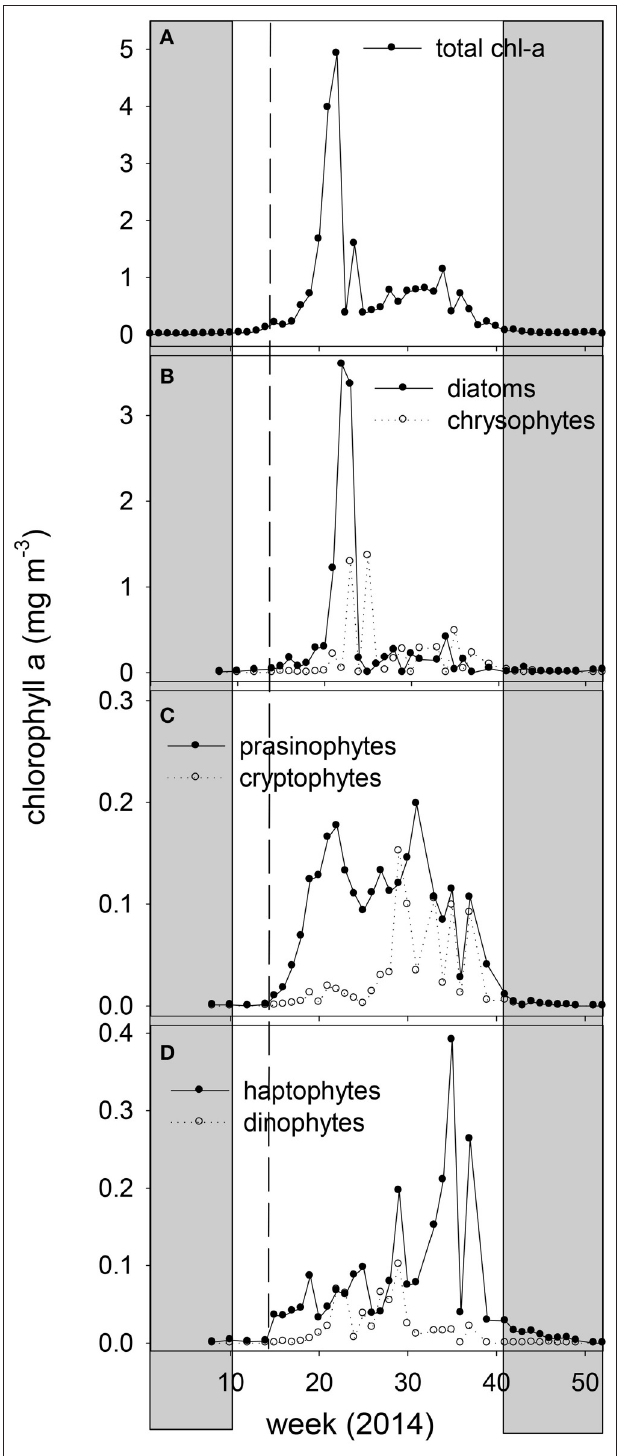
FIGURE 3 | Weekly averaged chlorophyll-a concentration of the 2014 ferry box samples (A) total chl-a, (B) chl-a of diatoms and chrysophytes, (C) chl-a of prasinophytes and cryptophytes, and (D) chl-a of haptophytes and dinoflagellates, derived by CHEMTAX analysis. The vertical dashed line marks the transition from non-stratified to stratified conditions. The shaded area indicates the polar night.